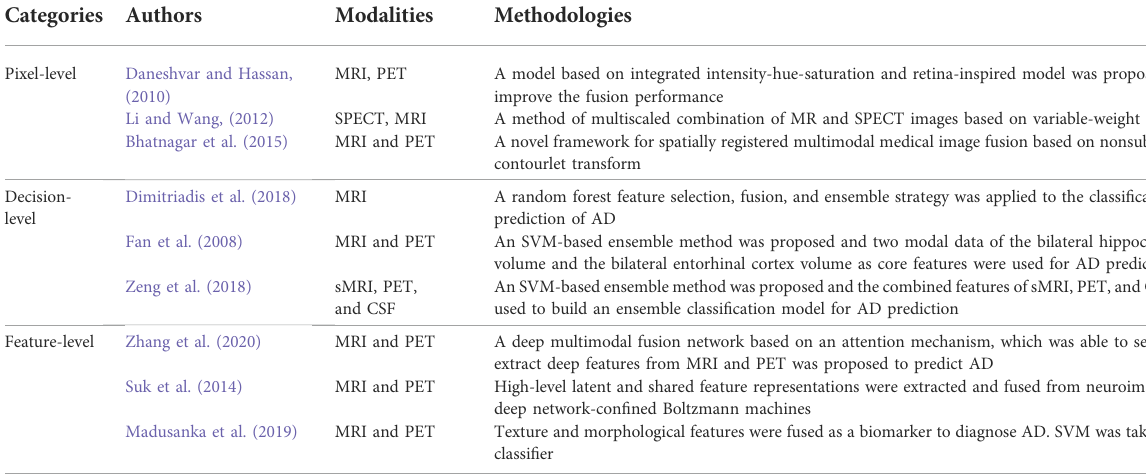
TABLE 1 Representative works of multimodality